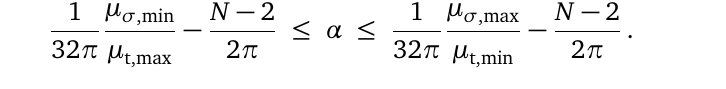
from positive bootstrap, com- t for different ∆ t min